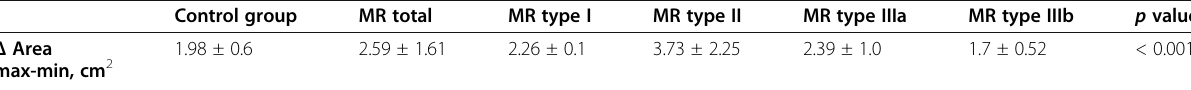
Table 4 Difference between maximal and minimal annular area measured through the cardiac cycle in control subjects and MR patients based on Carpentier ’ s